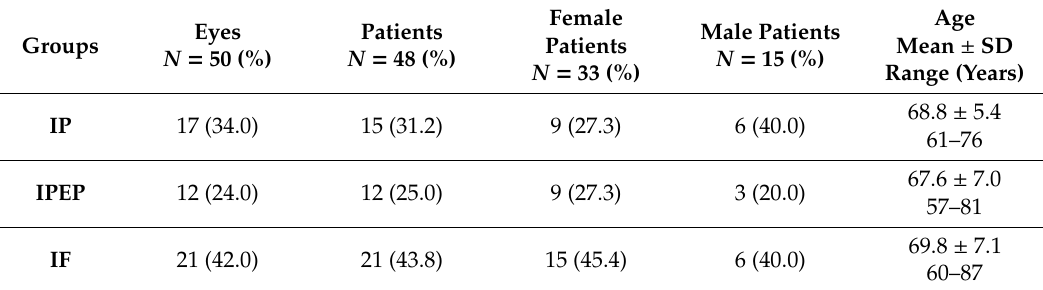
Table 1. Characteristics of the studied